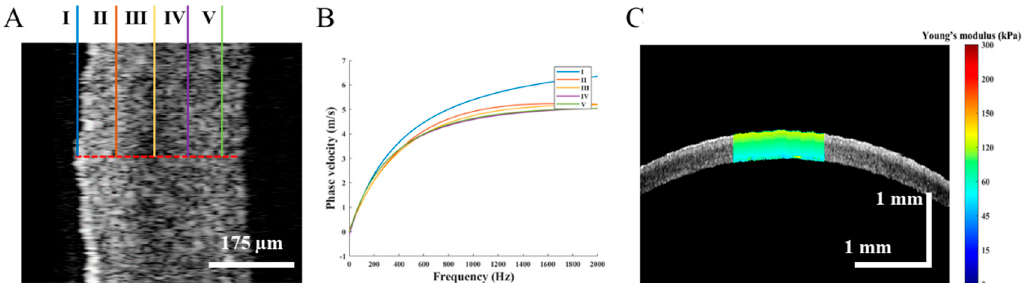
Figure 4. The different location Young’s modulus of the cornea, ( A ) is five different locations along the depth direction, ( B ) is the phase velocity curve of the Lamb wave at each location, and ( C ) is the depth-resolved Young’s modulus distribution of normal cornea.